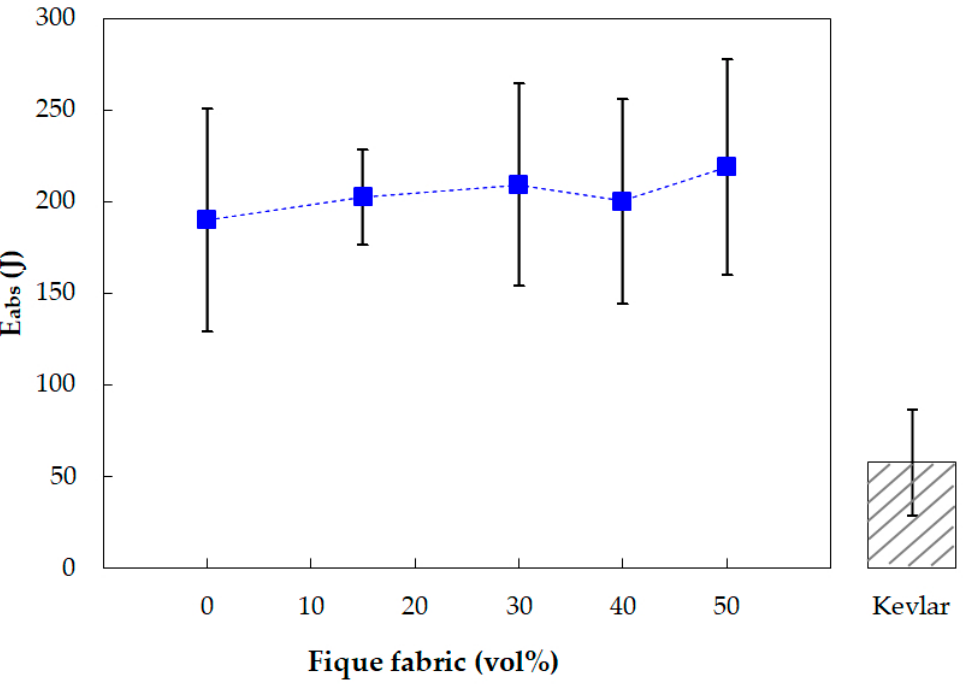
Figure 6. Variation of E abs from the stand-alone test with the volume fraction (vol%) of fique fabric. Reported E abs value for Kevlar TM indicated in adjacent bar [24].